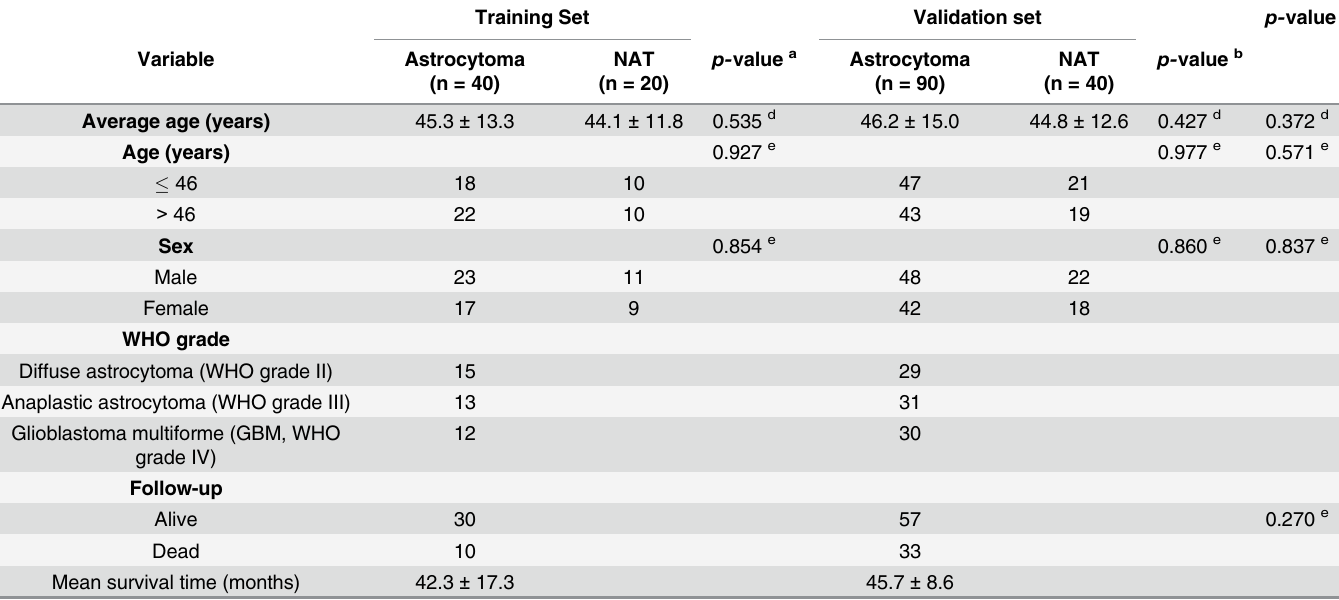
Table 1. Summary of the demographic and clinical features of the astrocytoma and NAT samples.